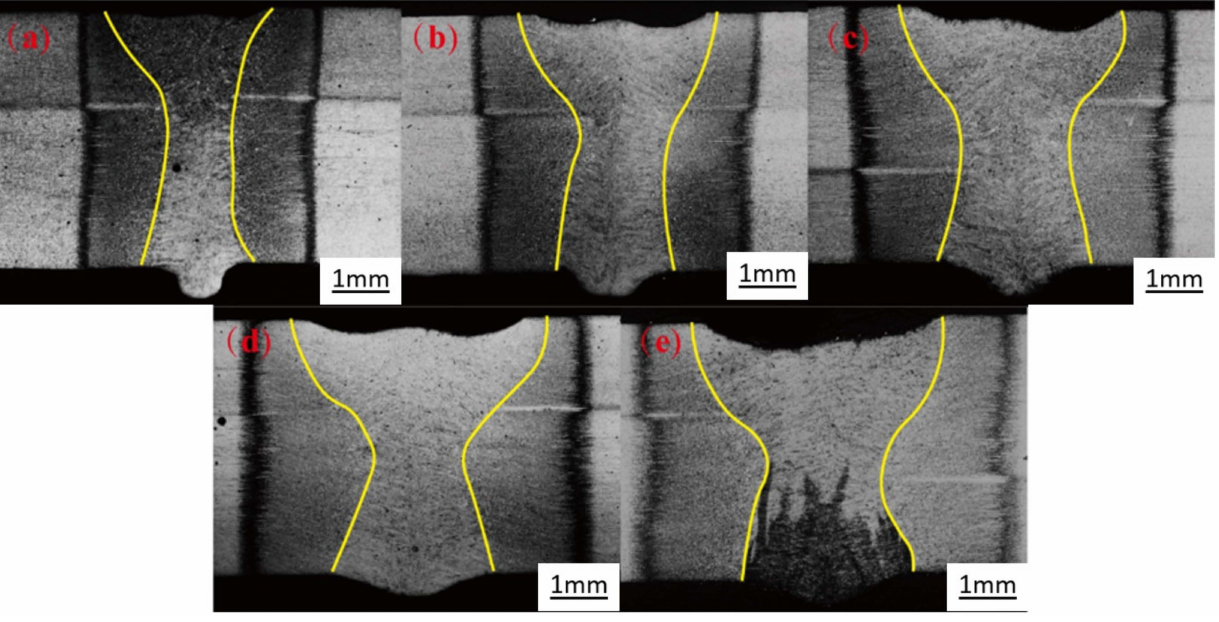
Figure 11. Macro morphology of the joint under different power: ( a ) 1800 W; ( b ) 2200 W; ( c ) 2600 W; ( d ) 3000 W; ( e ) 3400